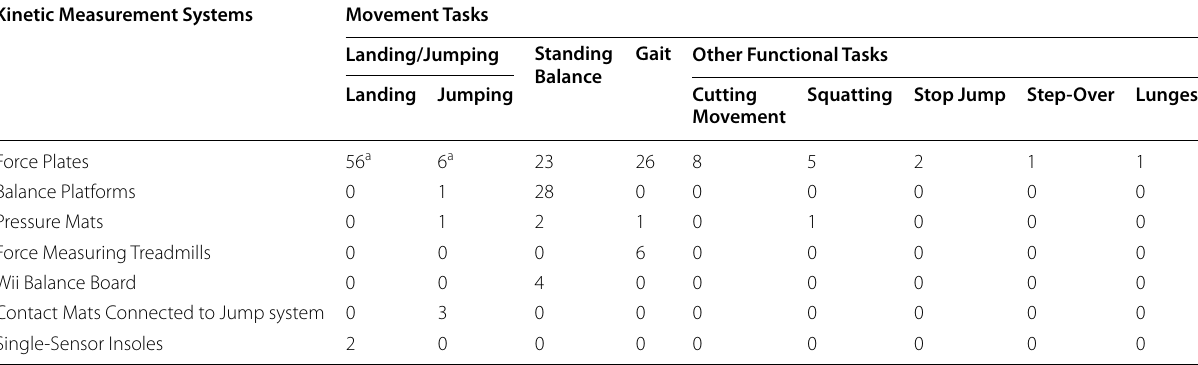
a Three studies assessed both jumping and landing and were included under both “Landing” and “Jumping” columns, bringing the total number of studies assessing landing and jumping using force plate to 59